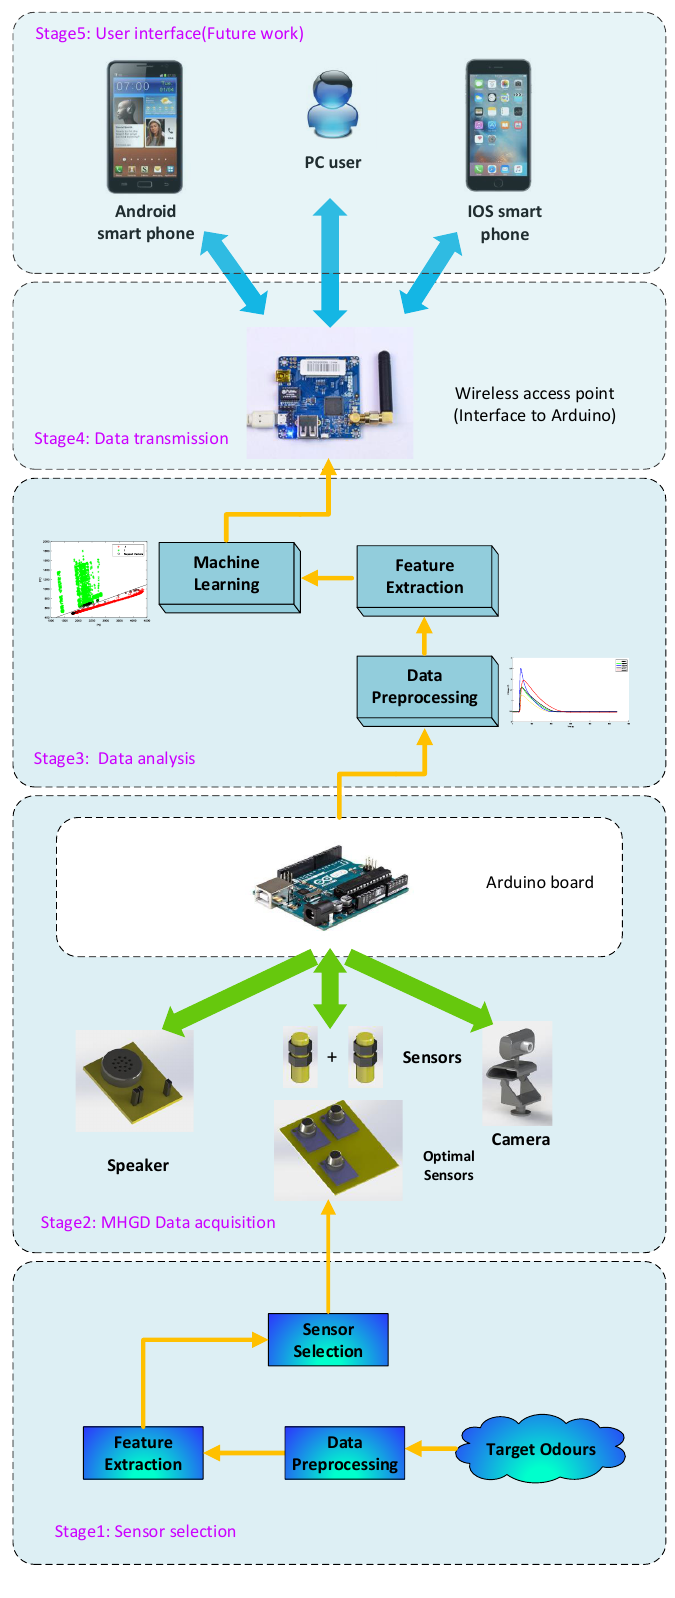
Figure 1. An overview of the proposed